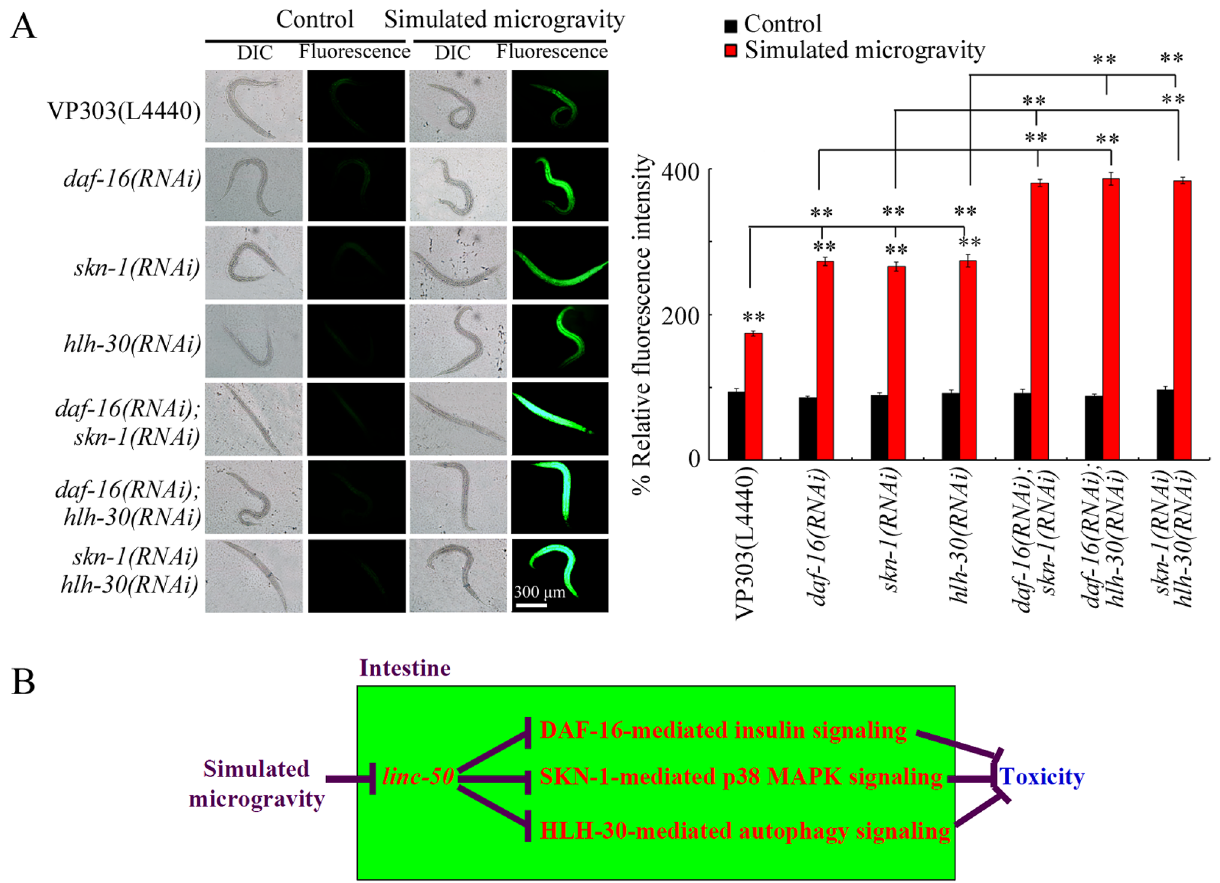
Figure 7. Genetic interaction among DAF-16, SKN-1, and HLH-30 in the intestine to regulate the response to simulated microgravity in nematodes. ( a ) Genetic interaction among DAF-16, SKN-1, and HLH-30 in the intestine to regulate the toxicity of simulated microgravity in inducing ROS production. N = 50. L4440, empty vector. Simulated microgravity treatment was performed in RCCS system at 30 rpm for 24 h. Bars represent means ± SD. ** P < 0.01 vs control (if not specially indicated). ( b ) A diagram showing the molecular basis of intestinal linc-50 in regulating the response to simulated microgravity in